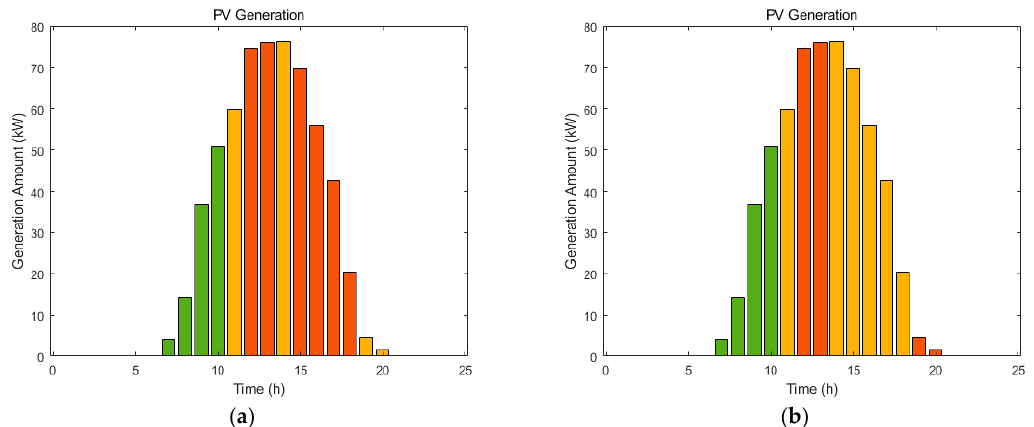
Figure A1. PV generation data: ( a ) 14 August 2017 (summer); ( b ) 25 January 2017 (winter). Table A1. Photovoltaic generation system (PV) data.